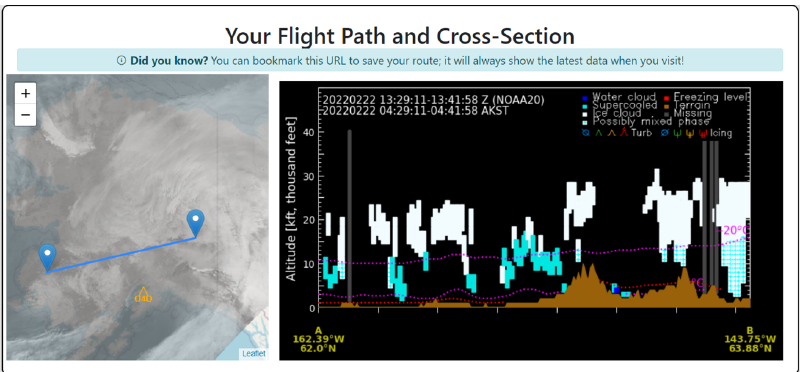
Figure 12. Sample Cloud Vertical Cross-section product from the CIRA new aviation website that allows users to select routes of their choice on a map to create a custom cross-section displaying cloud phase, altitude, terrain, turbulence, and icing information (https://aviation.cira.colostate.edu/, accessed on 31 October 2022). Allowing users to generate their customizable cloud cross-sections required addi- tional data processing, including the back-end construction of a fully gridded, 3D cloud field from the various datasets used for CVCs. Figure 13 shows a schematic diagram of the 3D cloud data processing. We are currently using a horizontal resolution of 0.02° × 0.02° with 51 vertical levels at 1000 ft resolution. Typical nearest neighbor and inverse- distance weighting interpolations are used, and the output is saved with compact 16-bit integers into a NetCDF file. CVCs are updated every time there is a JPSS satellite overpass, so users can watch for changing conditions. Archived cross-sections dating back four weeks are available for pre-selected routes. The custom cross-section product is currently available for Alaska, and preliminary output is also shown for other U.S. regions.